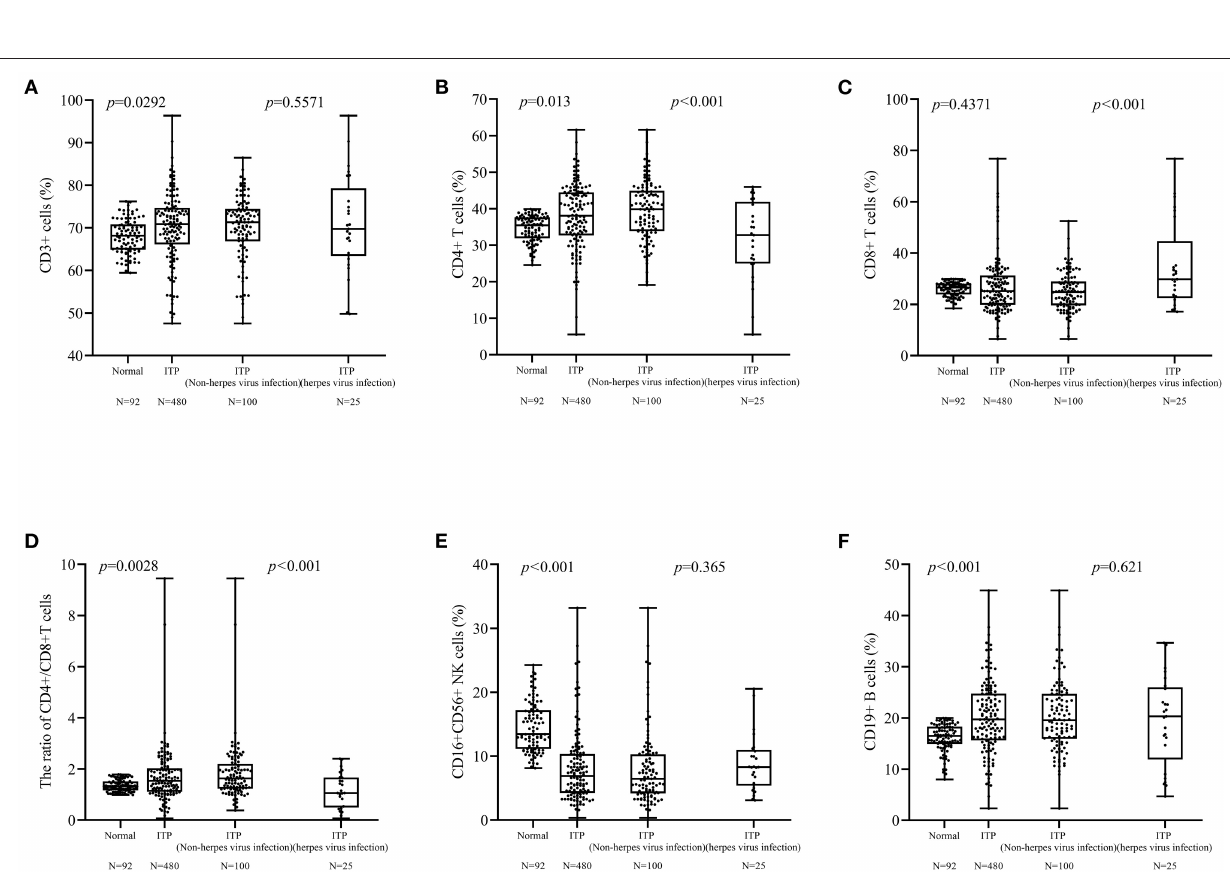
Frontiers in Pediatrics |